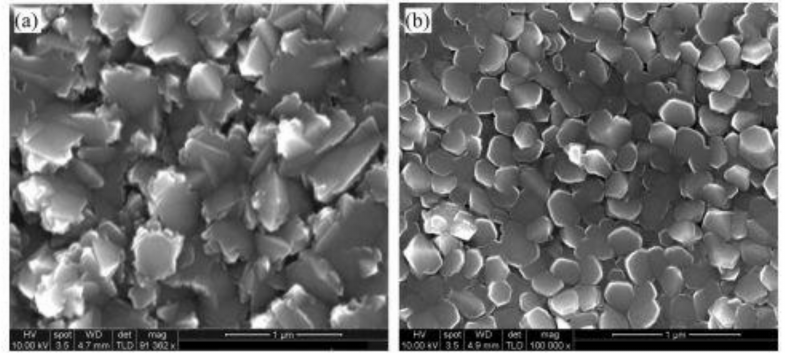
Figure 2. Morphology of RF sputtered Ti films on ITO glass ( a ) at room temperature and ( b ) at 300 ◦ C. Reprinted with the permission from reference